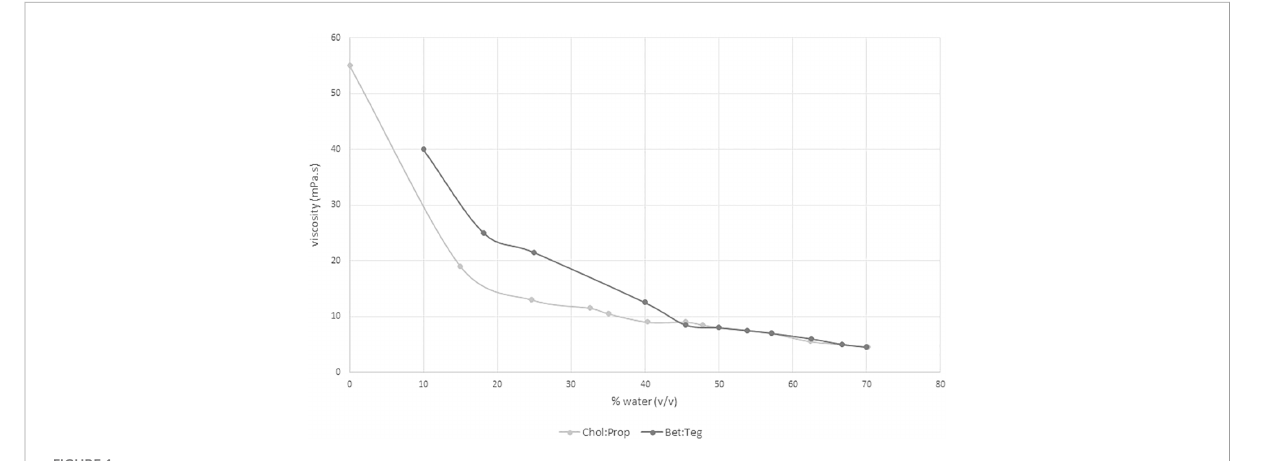
FIGURE 1 Viscosity evolution of both NADES with different dilution